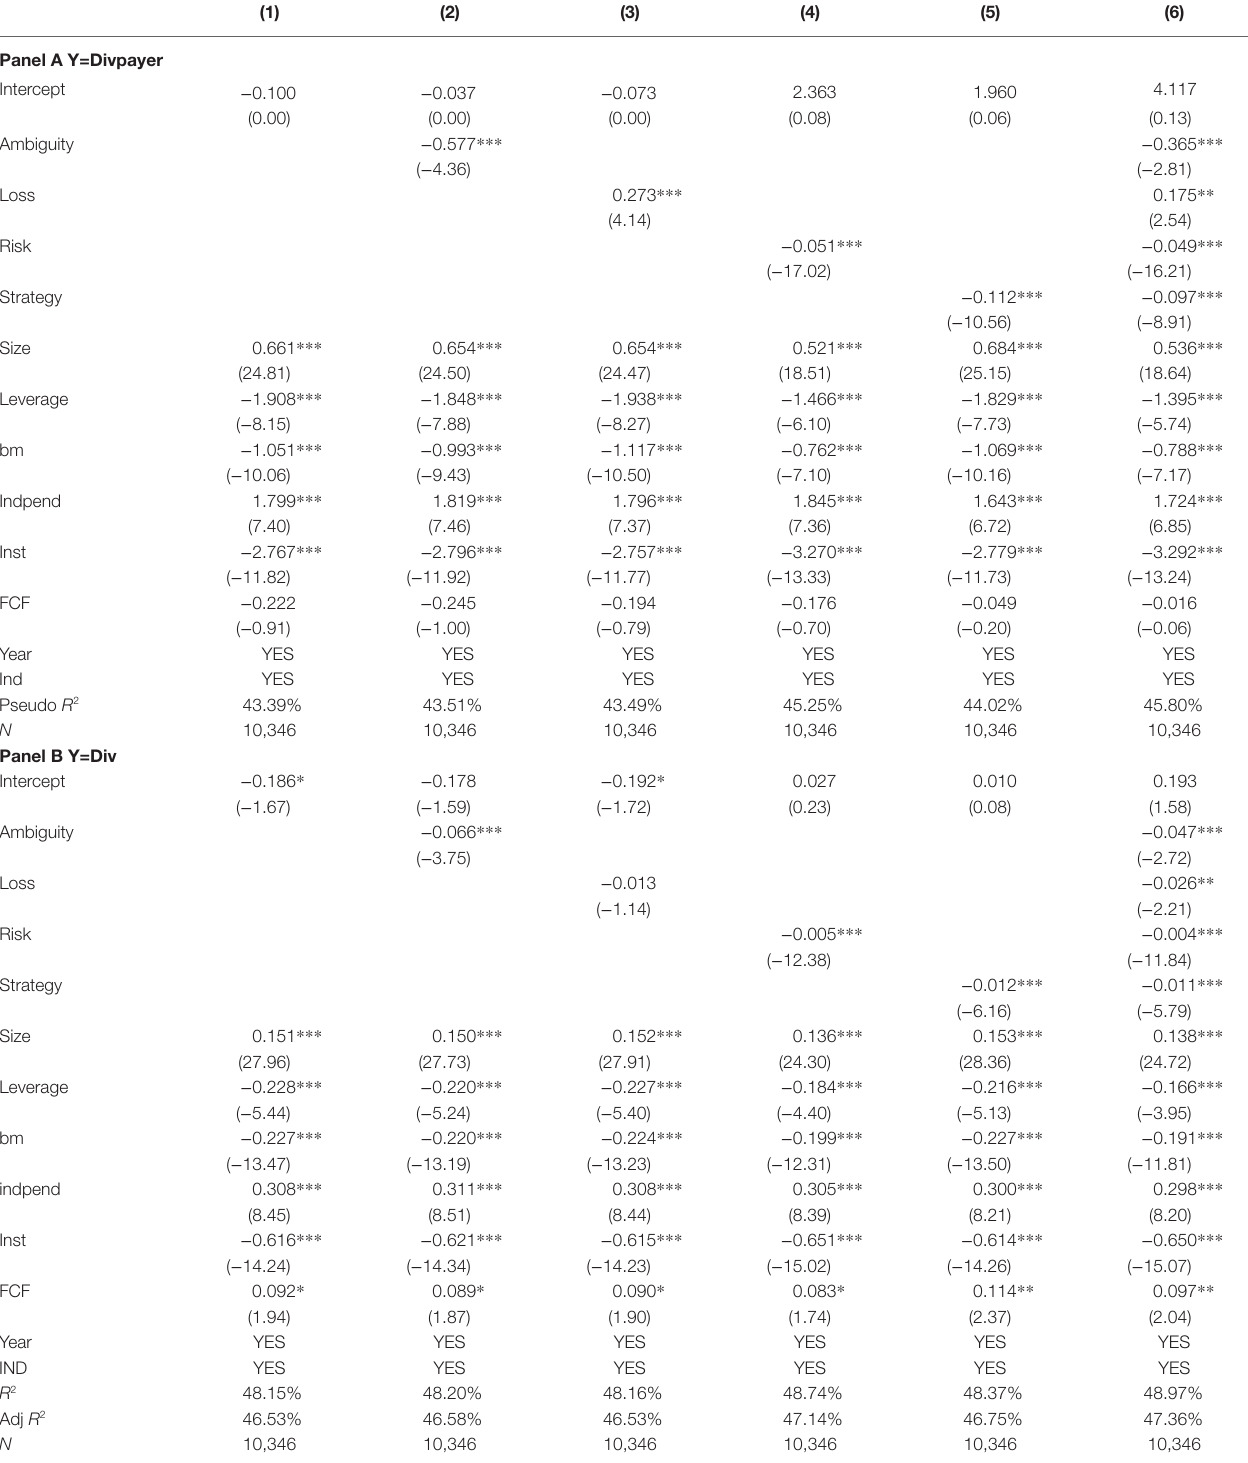
TABLE 4 | The influence of behavior foundations and business strategy on dividend